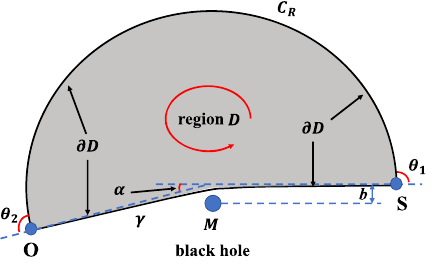
Fig. 1 Calculating the gravitational deflection angle using the Gauss– Bonnet theorem. This figure shows the choice of region D in the equa- torial plane of optical manifold for asymptotically flat spacetime, which makes the application of Gauss–Bonnet theorem in Eq. (10) available. Inthisfigure, O and S labelthelocationsofobserverandparticlesource. Thedirectionofboundary ∂ D inthecontourintegral to be counterclockwise. Note that for the particle orbit γ , this